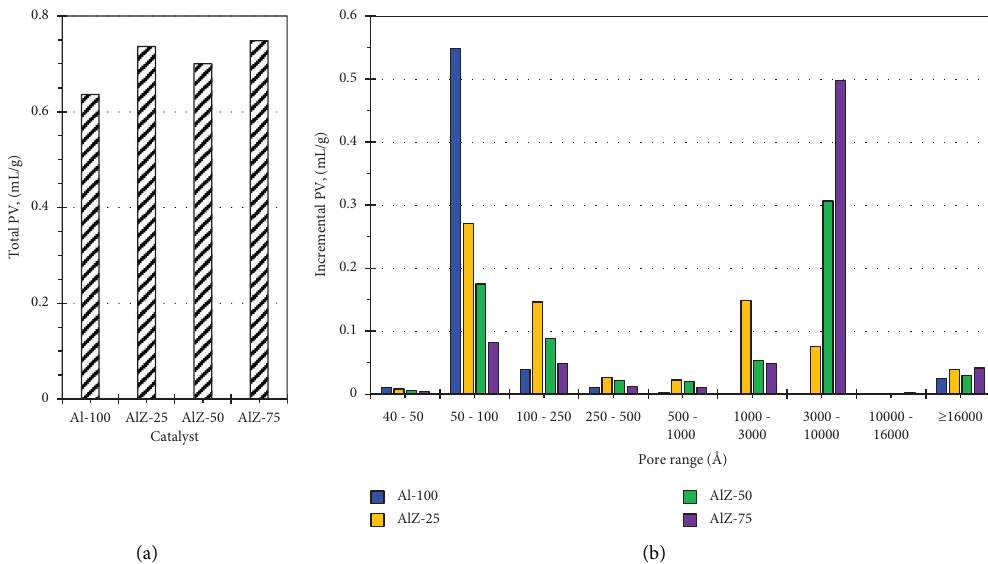
Figure 6: Variation of the total pore volume as a function of (a) catalyst composition and (b) range of pore size distribution.